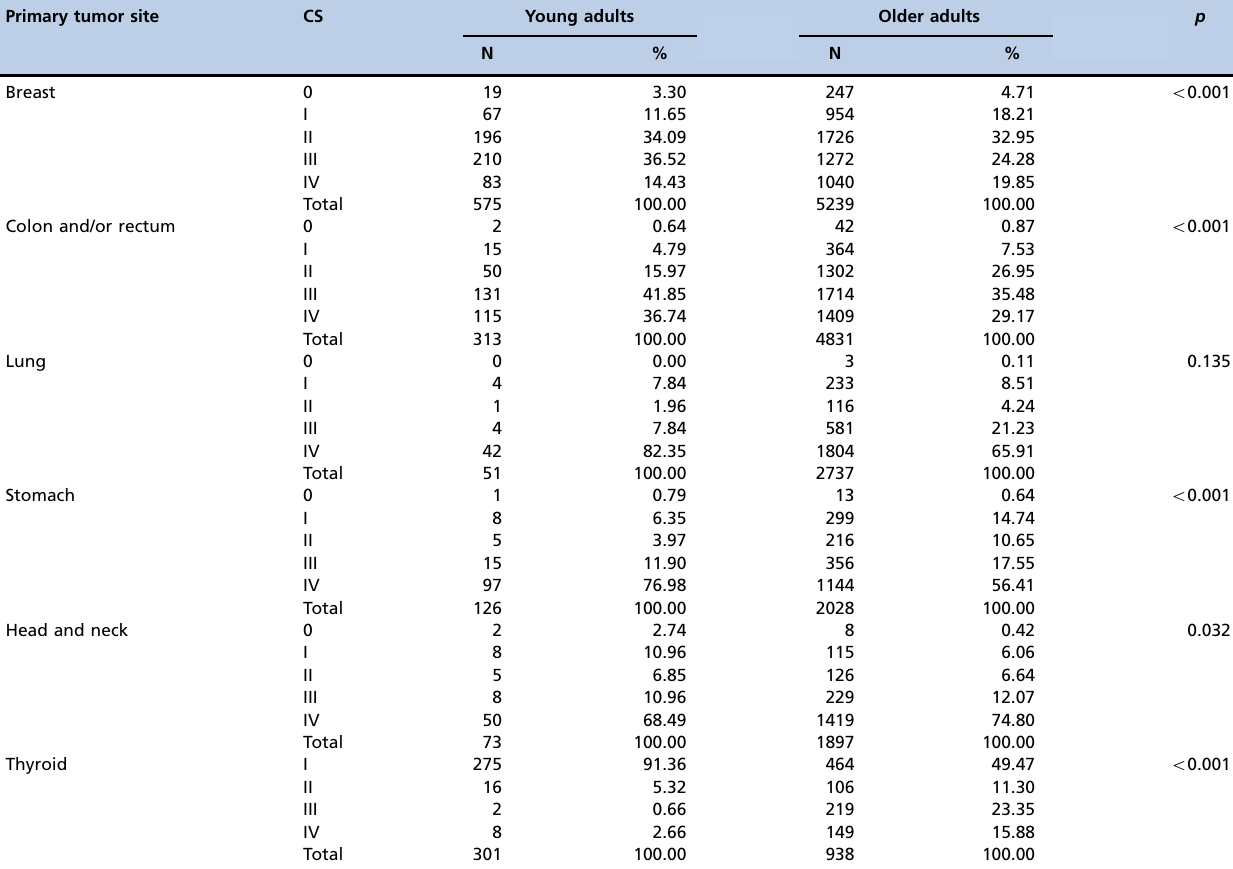
Table 1 - Clinical stage according to tumor site and age